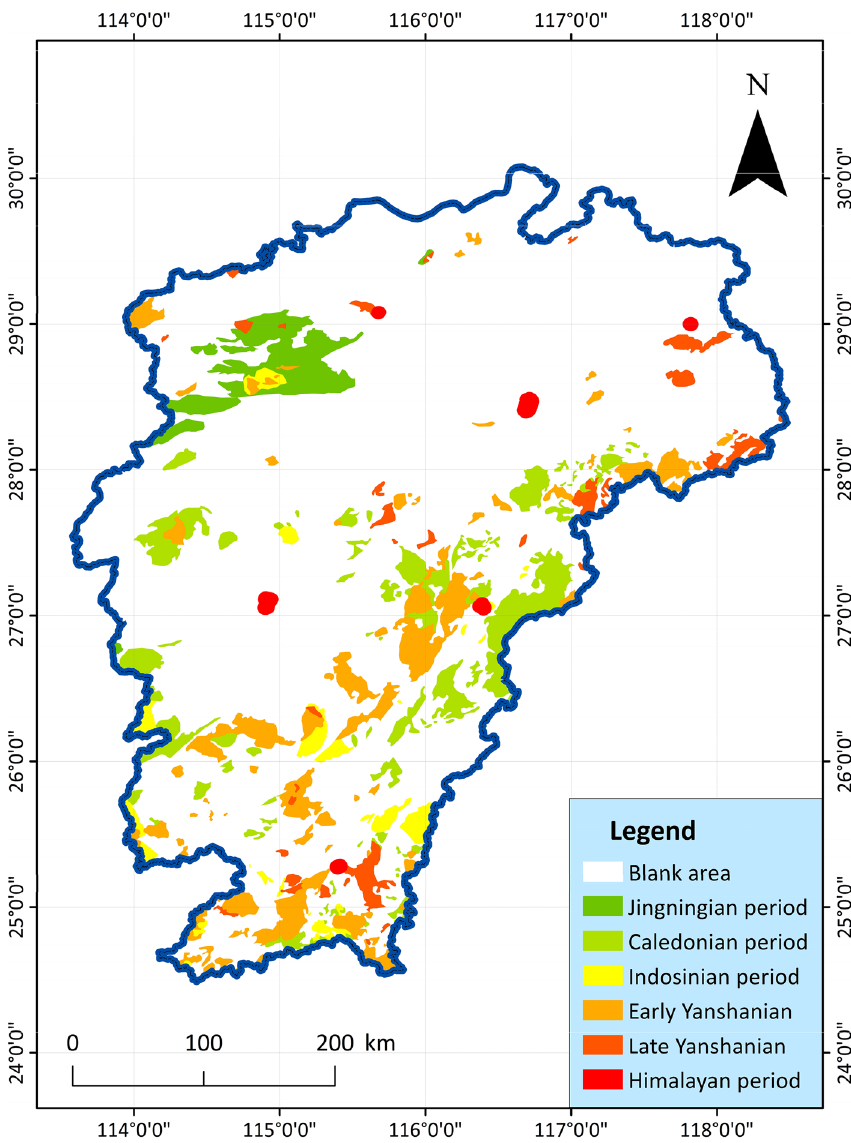
Figure 9. Spatial distribution map of Neoproterozoic-Cenozoic Era magmatic rocks in Jiangxi Province 64